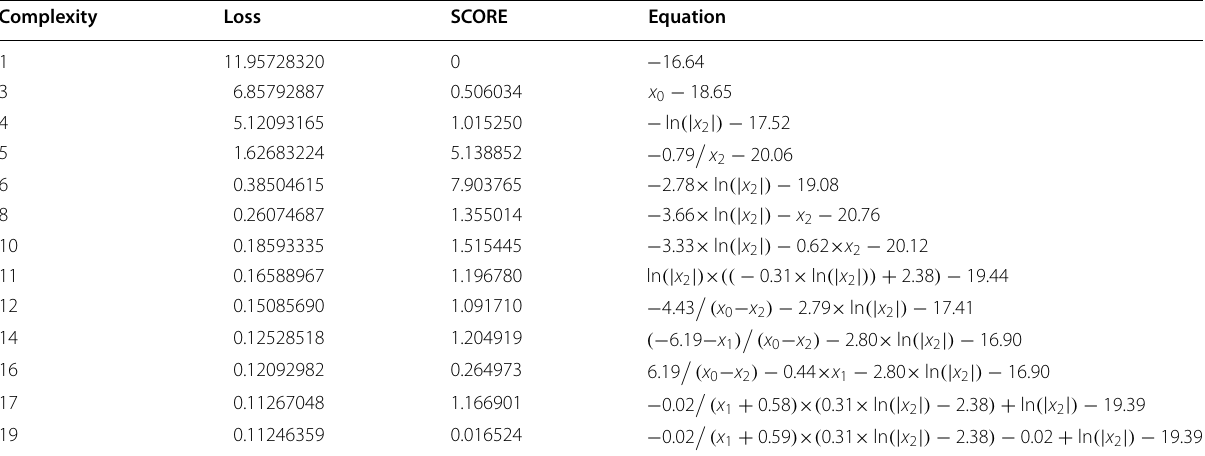
, x , and x represent lnΔ K , ln(1- R ), and ln(1-Δ K 0 1 2